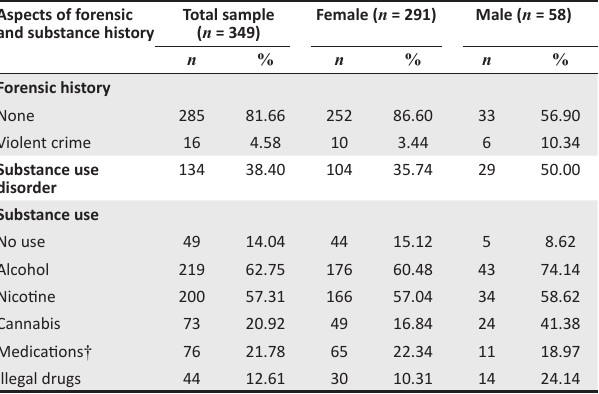
TABLE 4: Substance and forensic history in the total sample compared with female and male patients. Aspects of forensic Total sample and substance history ( n =